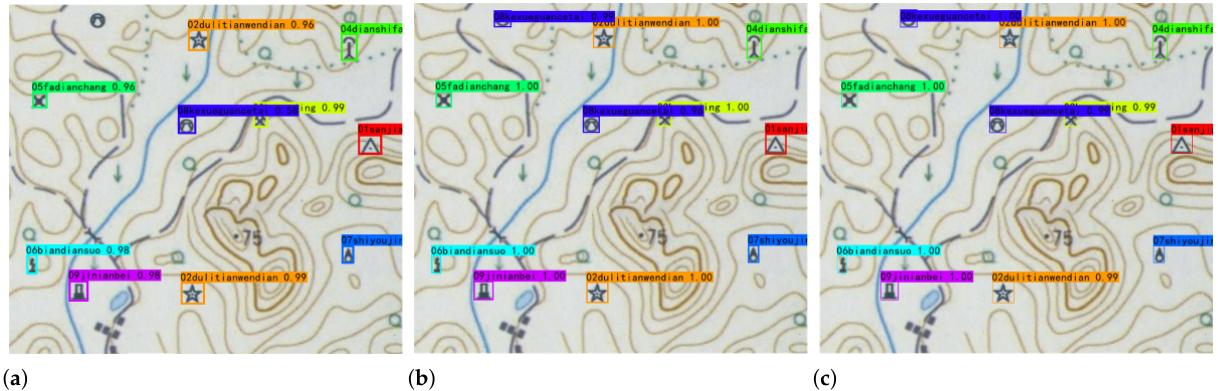
Figure 18. Results obtained for different input image sizes of Map E: ( a ) 320 × 320, ( b ) 512 × 512, and ( c ) 640 × 640 pixels.